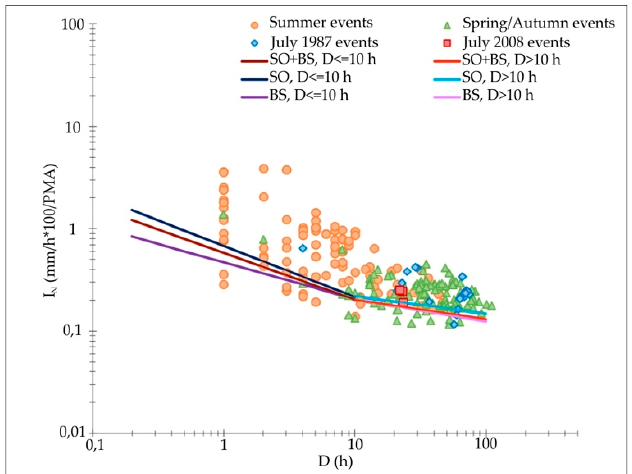
Figure 13. Comparison between the rainfall thresholds defined for Central- and South-Eastern Alps sector of the Lombardy Region (SO + BS) and the single Sondrio (SO) and Brescia (BS) Provinces.